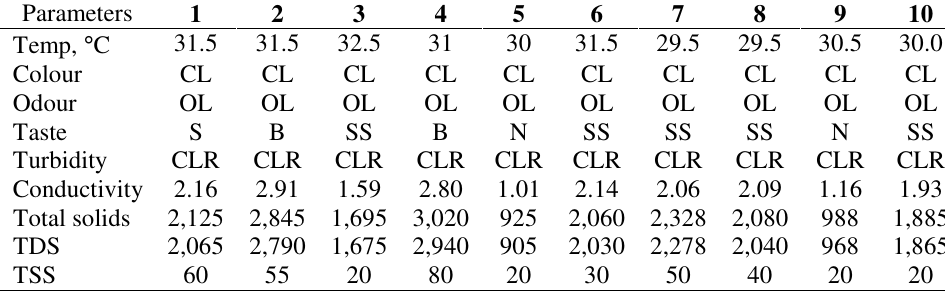
Table 1. Physical parameters, in mg/L